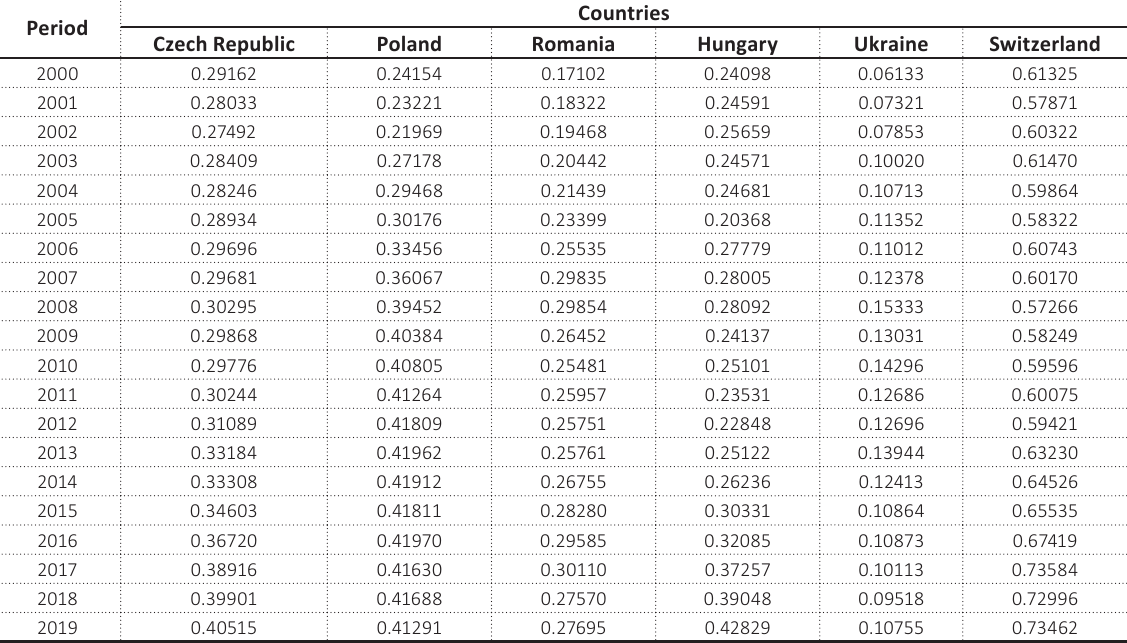
Table 2. Integral coefficients of the banking sector development of some EU countries, Switzerland, and Ukraine,